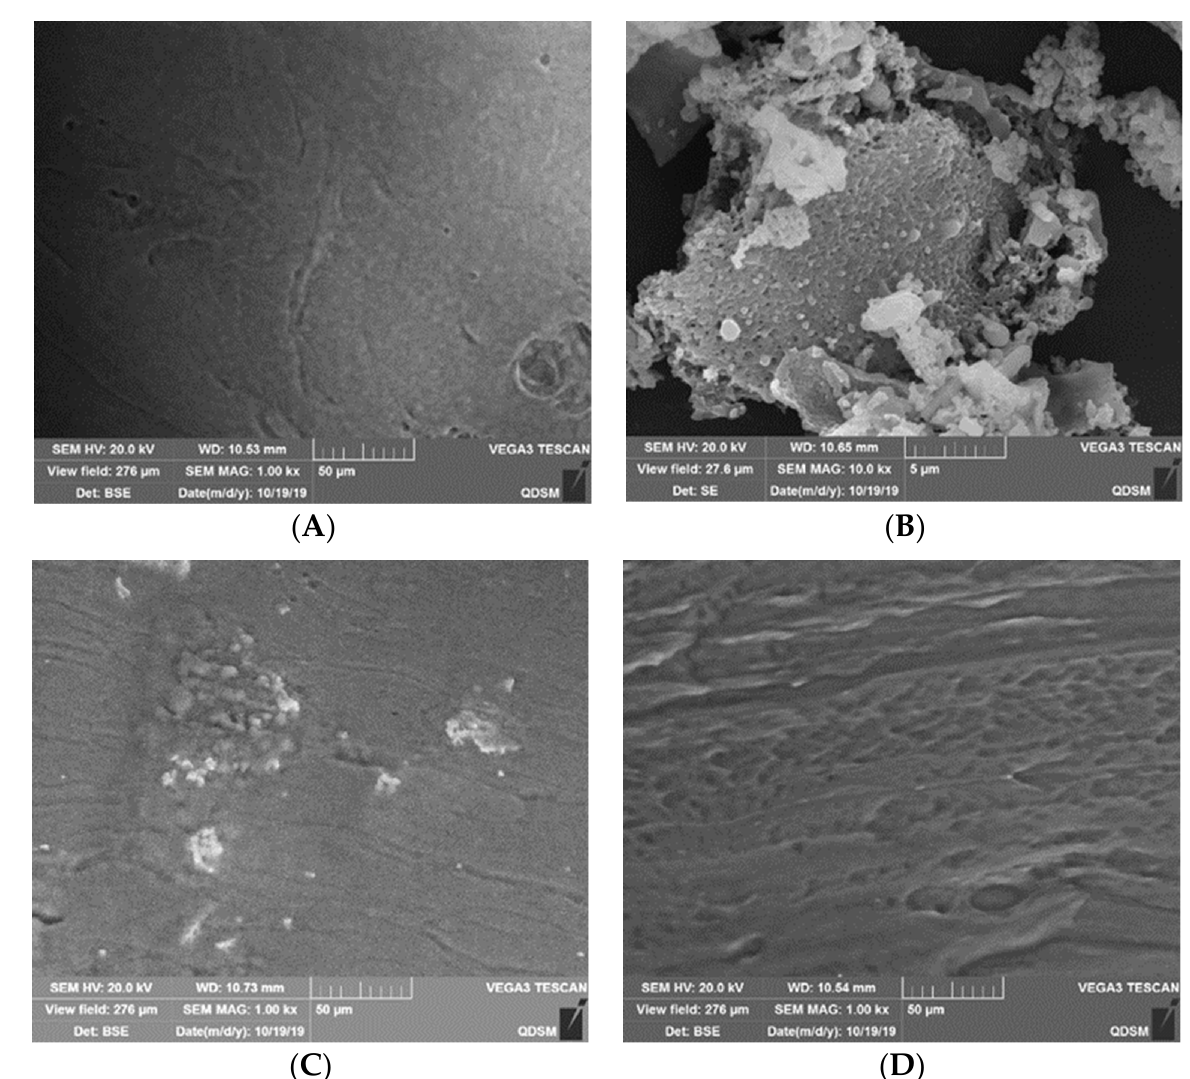
Figure 5. Scanning electron microscopy (SEM) of ( A ) phospholipids, ( B ) heparin, ( C ) physical mixture of heparin and phospholipids, and ( D ) the HEP–Pc complex.